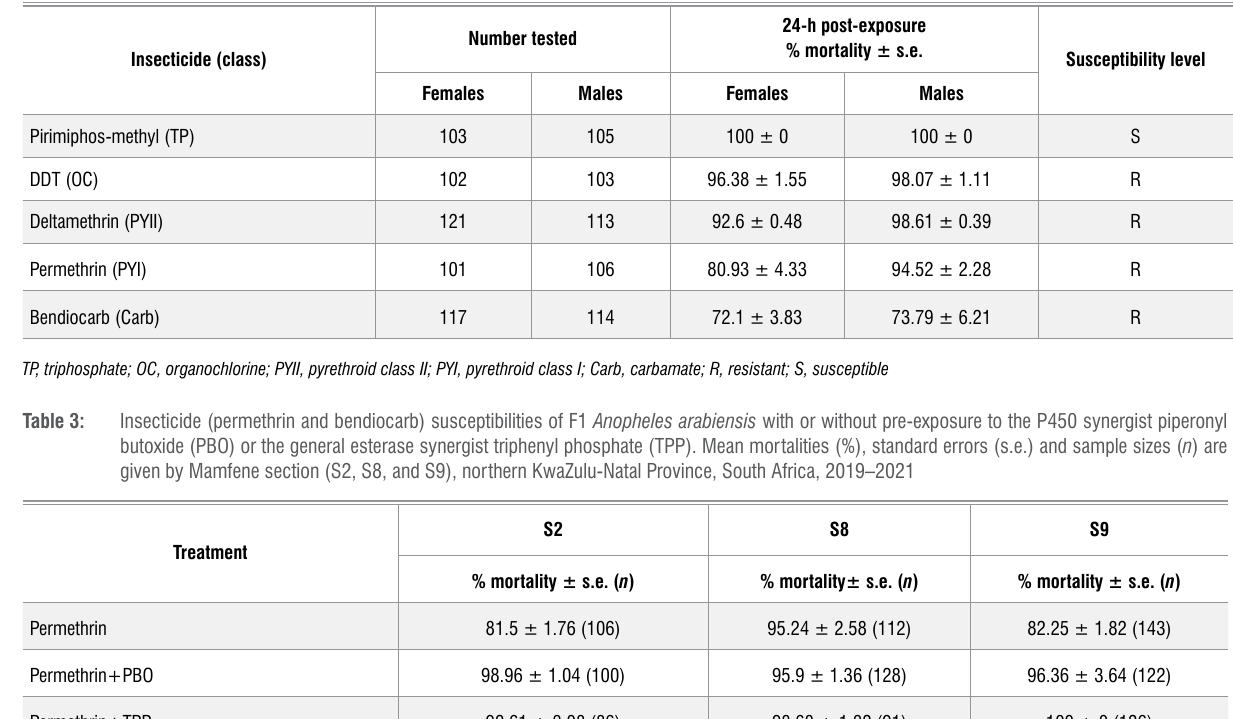
Anopheles arabiensis derived from wild-collected material from three sections of Table 2: Combined insecticide susceptibilities of male and female F 1 Mamfene, northern KwaZulu-Natal Province, South Africa, 2019–2021. Mean percentage mortalities (%), standard errors (s.e.) and sample sizes ( n ) are given by sex.